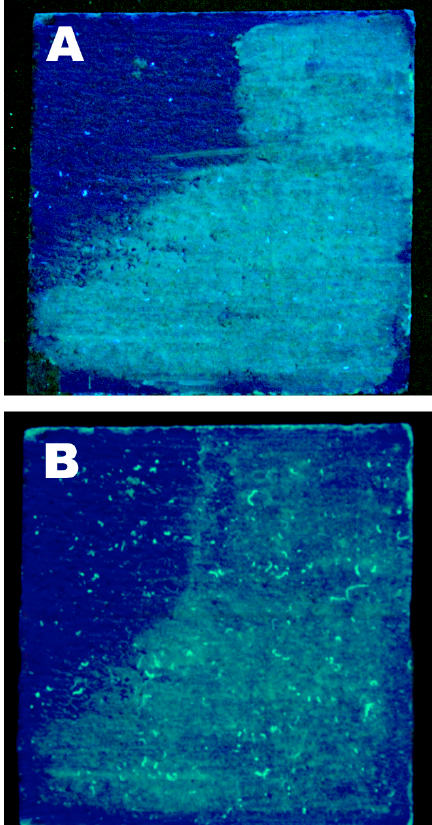
Figure 6. Wax removal tests performed in the laboratory. The picture shows one of the wax-stained tiles treated with the microemulsion ( A ) before and ( B ) after the cleaning. After the microemulsion application, the wax coating was thinned and partly removed. Some swollen wax was also moved on the surface, both by the microemulsion and by the subsequent mechanical action performed with a wet cotton swab. The luminescent spots in ( B ) are residues of cellulose fibers, due to the application of the cellulose powder poultices and could be almost completely removed by gently washing the surface with pure water after the